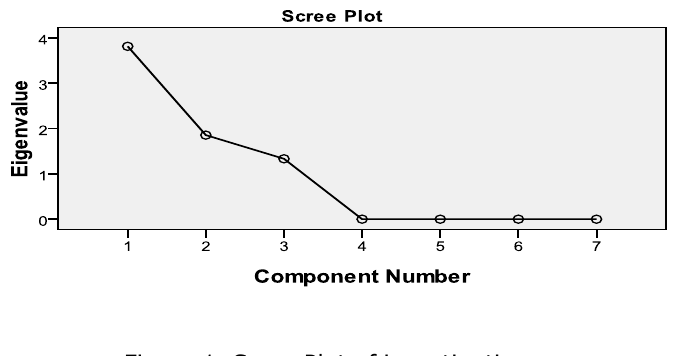
Figure 1. Scree Plot of